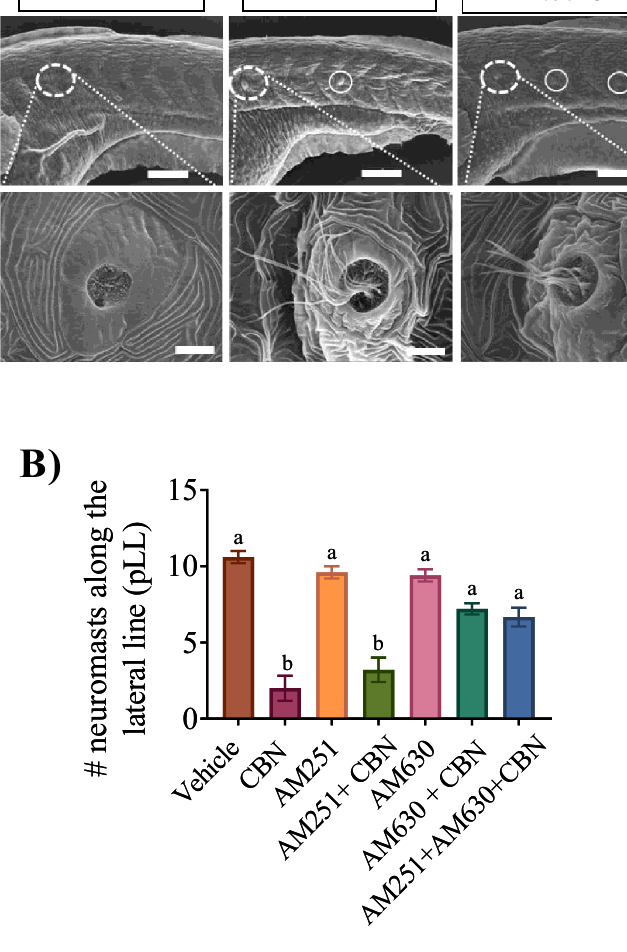
Figure 7. Blocking Cb1r and Cb2r activity prevents the CBN-induced changes in hair cell development along the pLL. ( A ) Images are taken along the pLL at ×500 magnification for 3 mg L −1 CBN (n = 5), AM251 10 nm + 3 mg L −1 CBN (n = 5), AM630 10 µm + 3 mg L −1 CBN (n = 5) and AM251 10 nm + AM630 10 µm + 3 mg L −1 CBN (n = 5). Scale bar represents 100 µm for the top row. N = 3 experiments. The bottom row shows higher magnification images of the pLL (×10,000 magnification). Scale bar represents 5 µm. ( I ) Bar graph showing the quantification of the percentage of the embryos that exhibited deformities in their hair cell along pLL. N = 3 experiments. Groups which share the same letter(s) of the alphabet are not statistically different from one another; p <